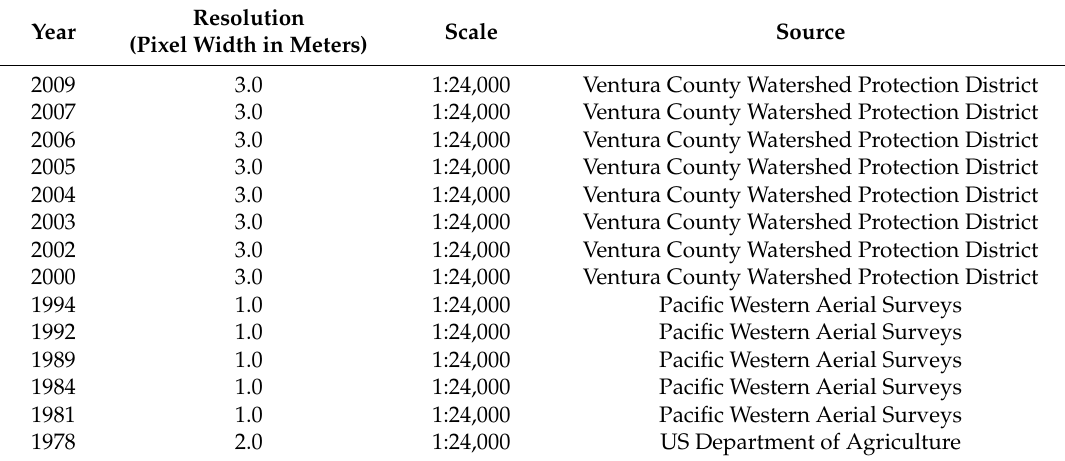
Table 2. Summary of aerial photograph information for site S2. See Figure 1 for location